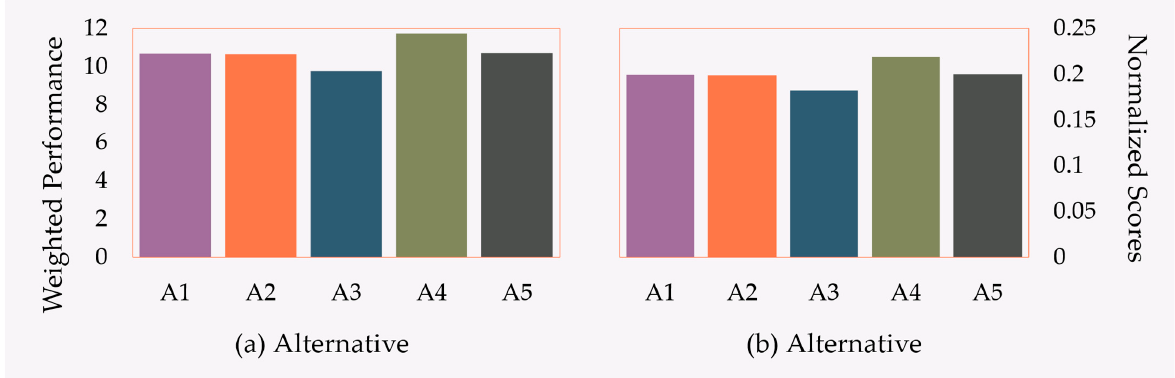
Figure 10. ( a ) Weighted performance matrix (performance scores of the alternatives across all sub- criteria), and ( b ) Normalized scores (relative performance of alternatives, calculated by dividing the weighted performance matrix scores by their sum).